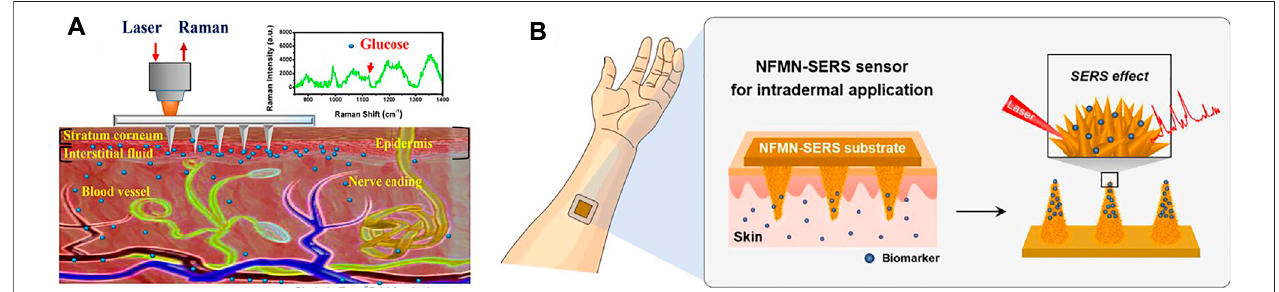
FIGURE5|(A) Schematicdiagramofthetransdermaldetectionofglucose invivo usingtheF-PMMAMNarraybasedonsurface-enhancedRamanspectroscopy. Reproduced with permission (Ju et al., 2020). Copyright 2020, American Chemical Society. (B) Scheme of the NFMN-SERS sensor for an intradermal detection. The inset image shows the fl ower-like nanostructures formed on the MN structure. Reproduced with permission (Li H. et al., 2021). Copyright 2021, Elsevier.